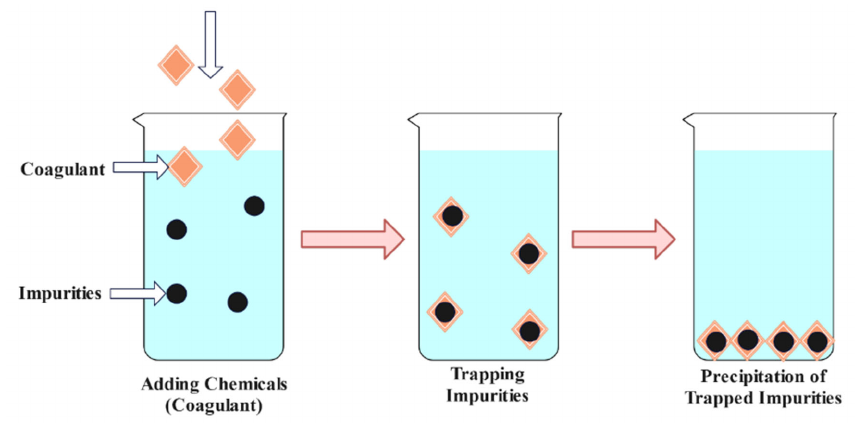
Figure 5. Chemical precipitation technique [84].